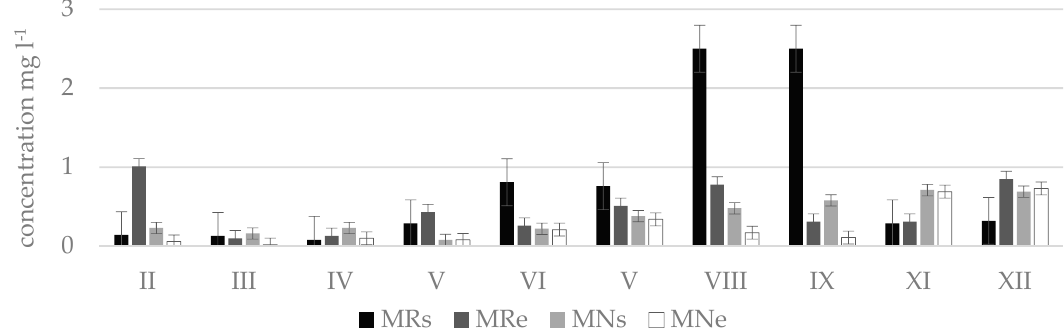
Figure 6. Phosphate concentrations ( PO (cid:2872)(cid:2871)(cid:2879) ) in natural (N) and regulated (R) stretches of M ė kla stream.